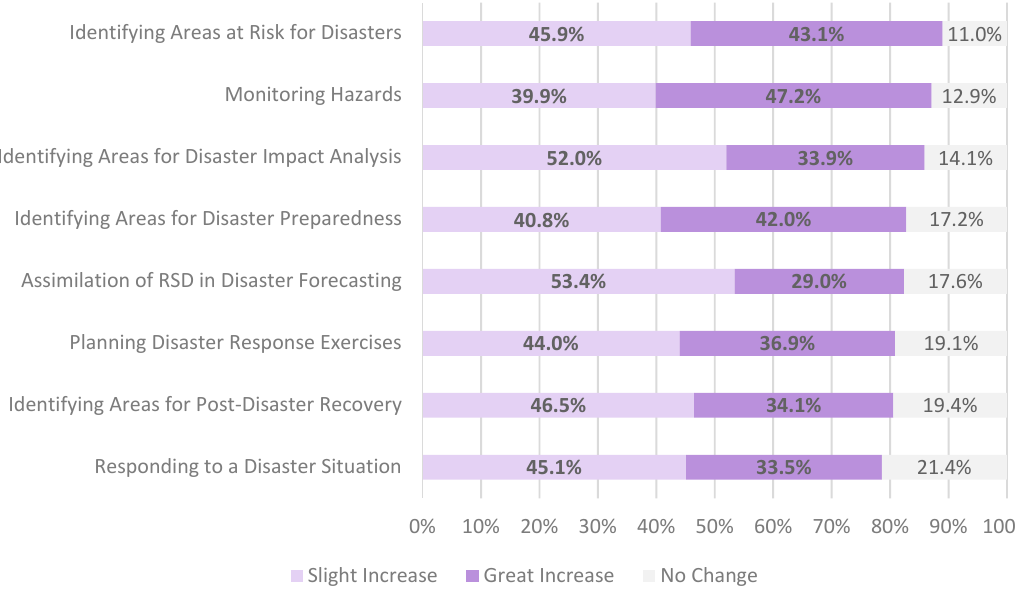
Figure 8. Change in use of RSD as a result of ARSET for disaster management. Light purple = slight increase; dark purple = great increase; gray = participants for whom the task was applicable, but who indicated no change in their use of RSD for that task ( N = 168–181, with 2–10 claiming the task was not applicable).